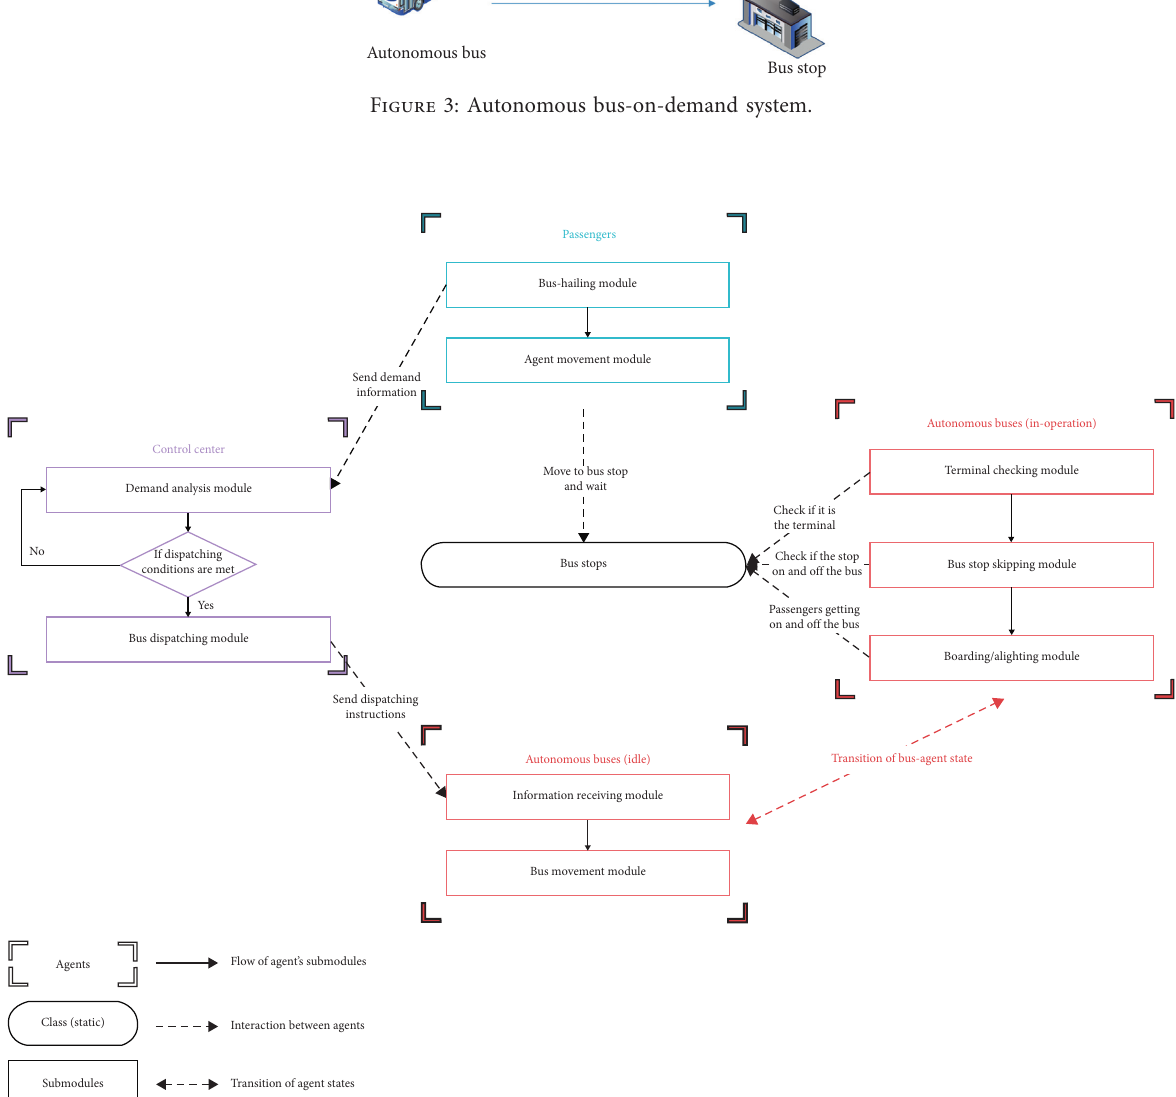
Figure 4: Agent-based simulation of passengers, control center, and autonomous